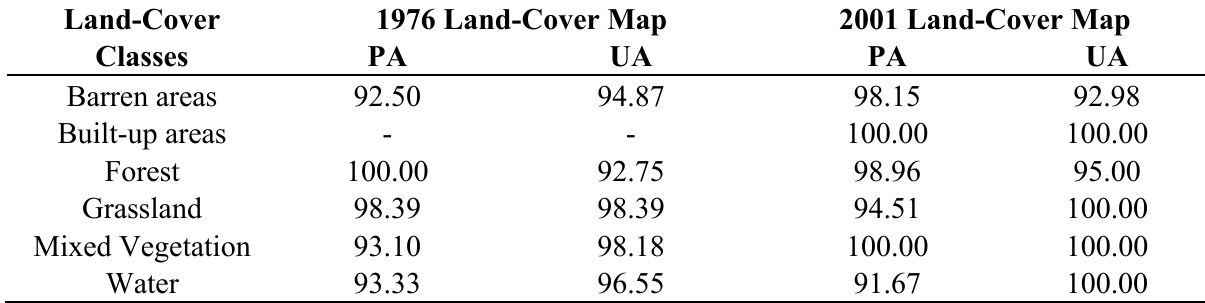
Table 3. Producer’s (PA) and User’s Accuracy (UA) of the land-cover maps (in